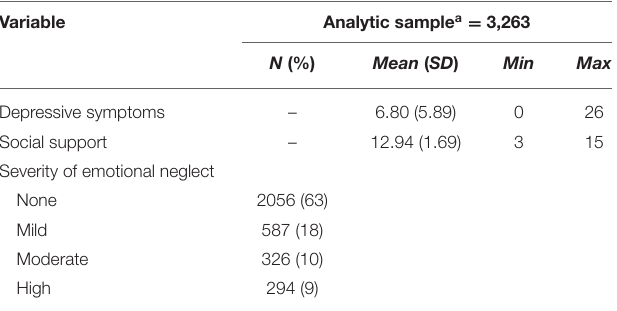
TABLE 2 | Descriptive statistics for depressive symptoms, social support, and childhood emotional neglect variables in the analytic sample ( n = 3,263).